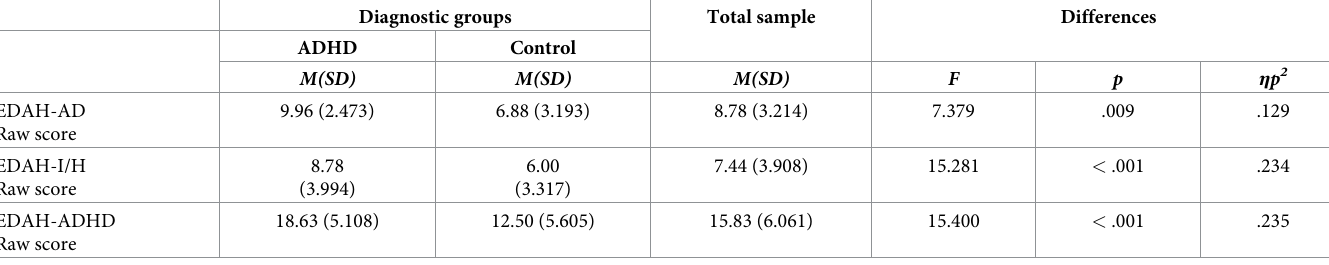
Table 1. ADHD symptoms in the diagnostic groups and differences (as per EDAH